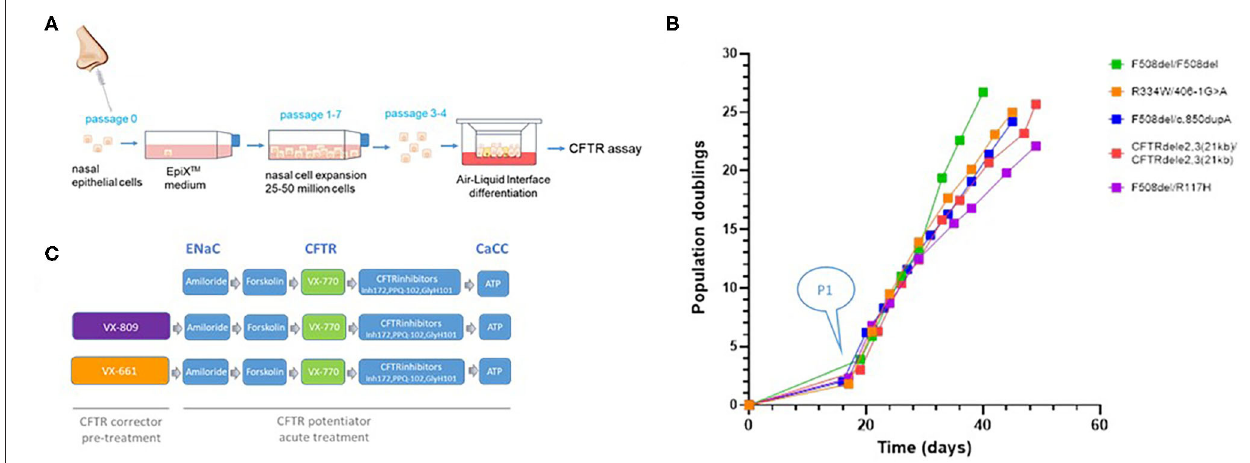
FIGURE 2 | Schematic overview of nasal cell expansion in EpiX TM medium and Ussing chamber protocol. (A) Nasal epithelial cells were collected from five CF individuals by nasal brushings. Isolated primary cells were expanded with the EpiX TM method in Keratinocyte-SFM medium with TGF- β inhibitor A83-01 (1 uM), Rho-Kinase inhibitor Y-27632 (5 uM), isoproterenol (3 uM), and low calcium concentrations (CaCl 2 ; 90 uM), as previously described ( 6). Expanded cells were plated on Snapwell inserts at Passage 3 or 4 and subsequently grown in a serum-free medium at an air-liquid interface for 21–28 days for differentiation. (B) Population doublings. The initial “lag phase” illustrates the number of days it took to generate CF airway cultures (passage 1) from the primary cells (P0) that were isolated from the brushed tissue sample. Each CF culture reached ∼ 25 population doublings within 25–35 days. (C) Activities for ENaC, CFTR, and CaCC were assessed